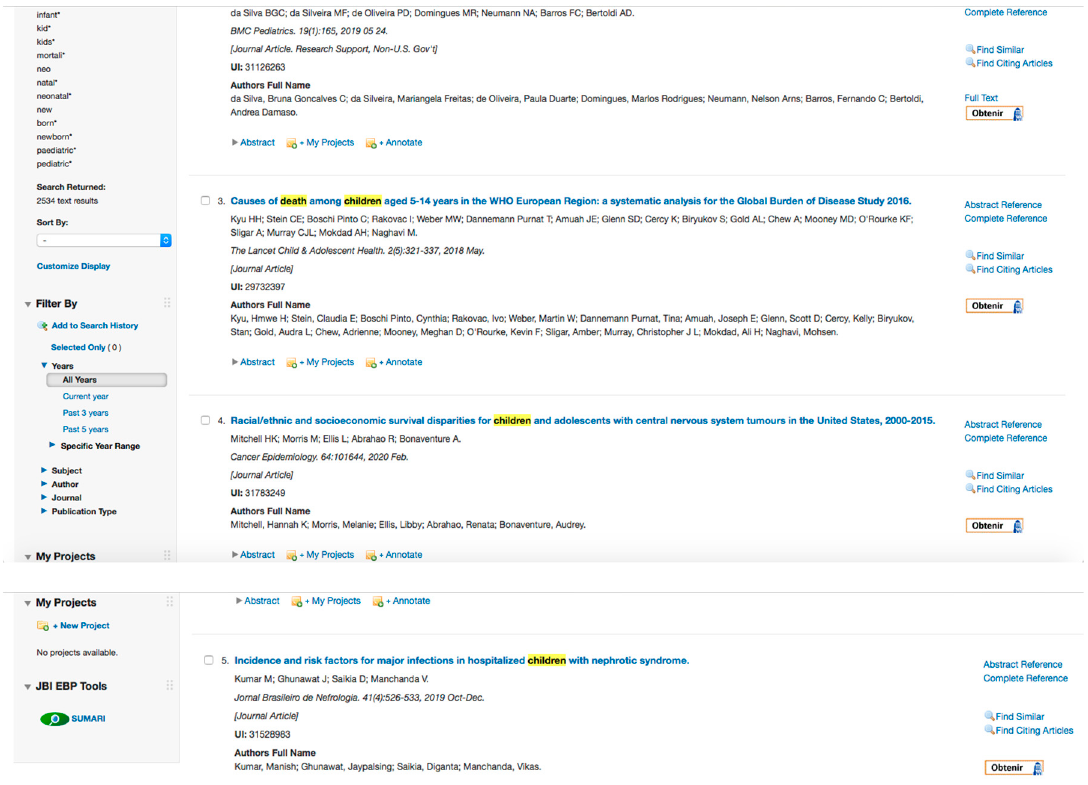
Figure A1. Screen shot research: MEDLINE. Table A3. LILACS (Concept 1 = 1522 references; concept 2 = 213 references; total = 1735).